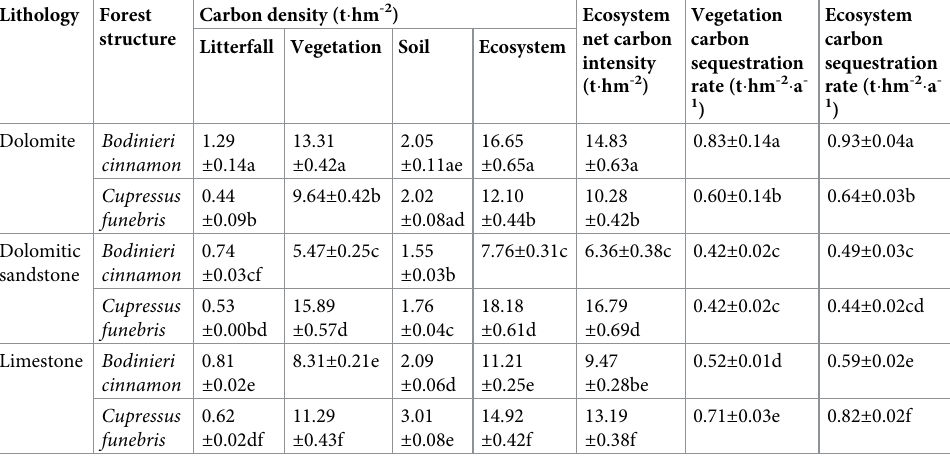
Table 12. Carbon density and carbon sequestration rate in the two plantation forest ecosystems under different lithologies. Lithology Forest Carbon density (t � hm -2 structure